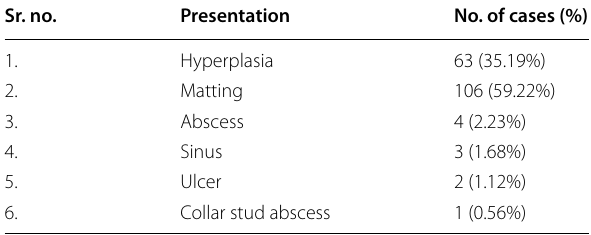
Table 3 Clinical signs in the patients with TB lymphadenitis Sr. no.